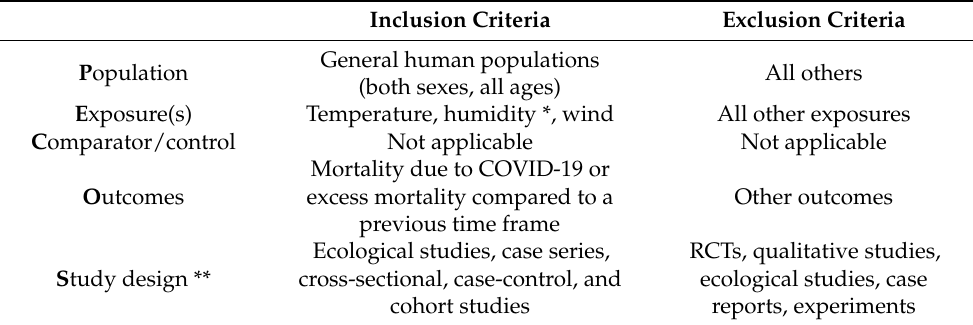
Table 1. Eligibility criteria according to population, exposure, comparison, outcome of interest, and study design. Inclusion Criteria Exclusion Criteria General human populations P opulation All others (both sexes, all ages) E xposure(s) Temperature, humidity *, wind All other exposures C omparator/control Not applicable Not applicable Mortality due to COVID-19 or O utcomes excess mortality compared to a Other outcomes previous time frame Ecological studies, case series, RCTs, qualitative studies, S tudy design ** cross-sectional, case-control, and ecological studies, case cohort studies reports,